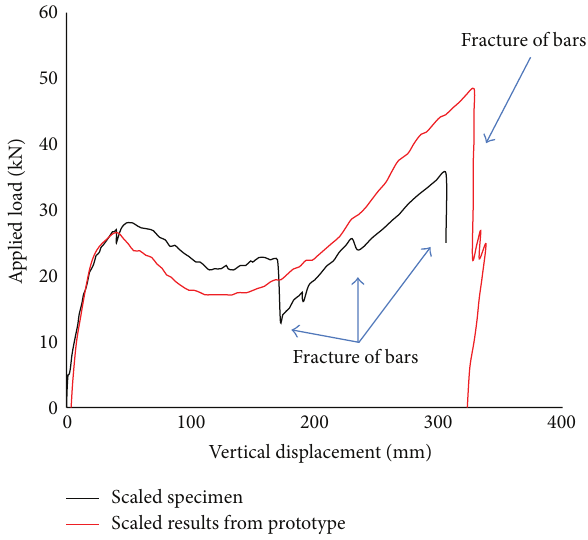
Figure 10: Comparison of results from scaled specimen and scaled results from